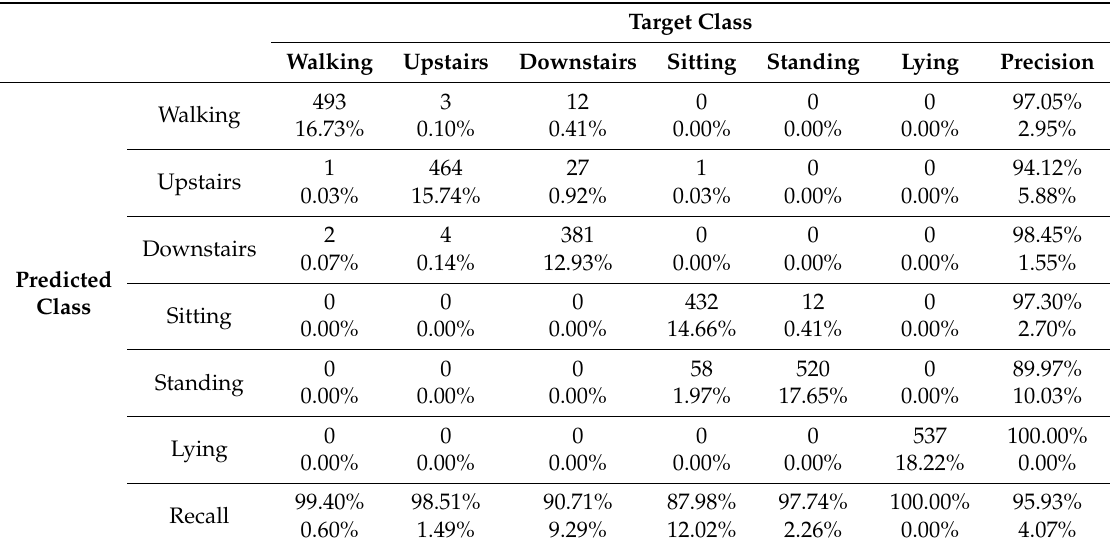
Table 3. Confusion matrix of HAR based on automatic feature extraction.